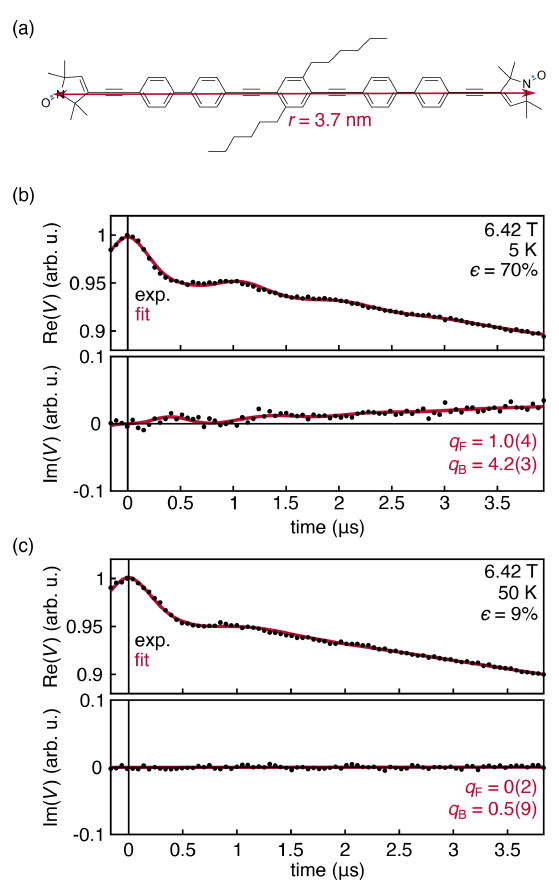
Figure 5. (a) Nitroxide biradical with an inter-spin distance of 3.7nm (Schöps et al., 2015, 2016). Experimental DEER traces for a 0.25mM solution of the biradical in deuterated toluene, measured at 180GHz and 6.42T at 5 (b) and 50K (c) . The data were fit with Eqs. (14)–(16). Fit parameters are shown with their 95% confidence interval. All fit parameters are listed in Table